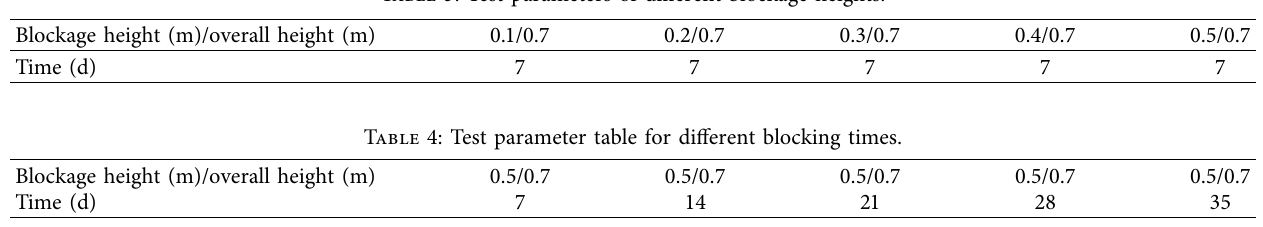
Table 3: Test parameters of different blockage heights.